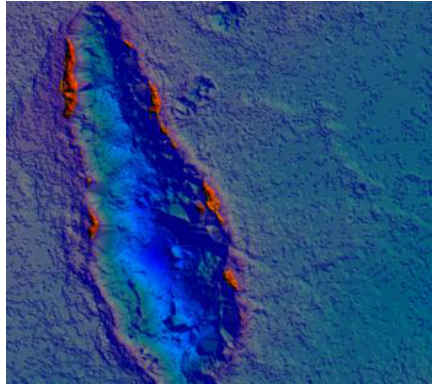
Figure 6. DEM results of H8433